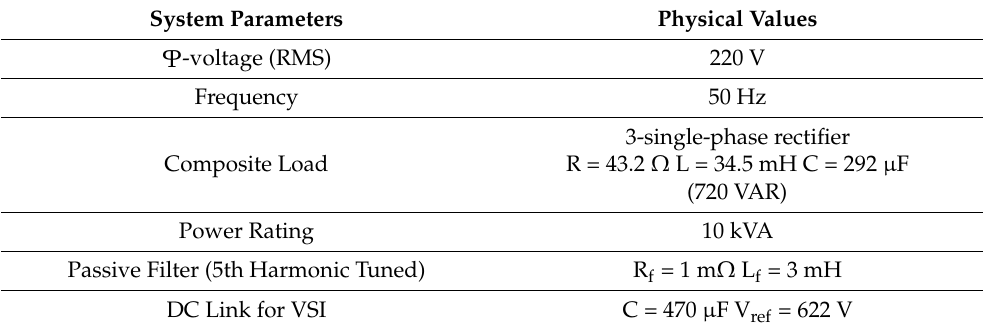
Table 1. Power system specifications for the research.